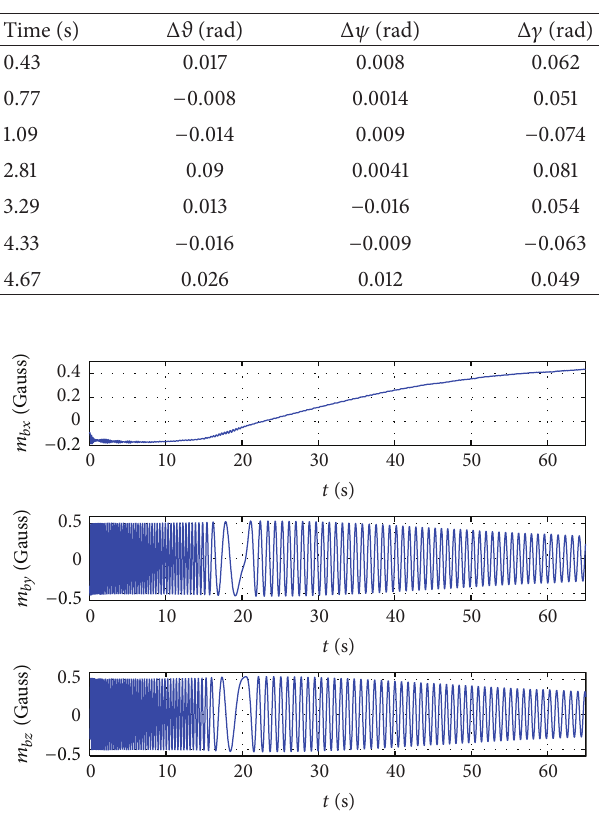
Figure 3: Measurement data of the triaxial magnetic sensor.